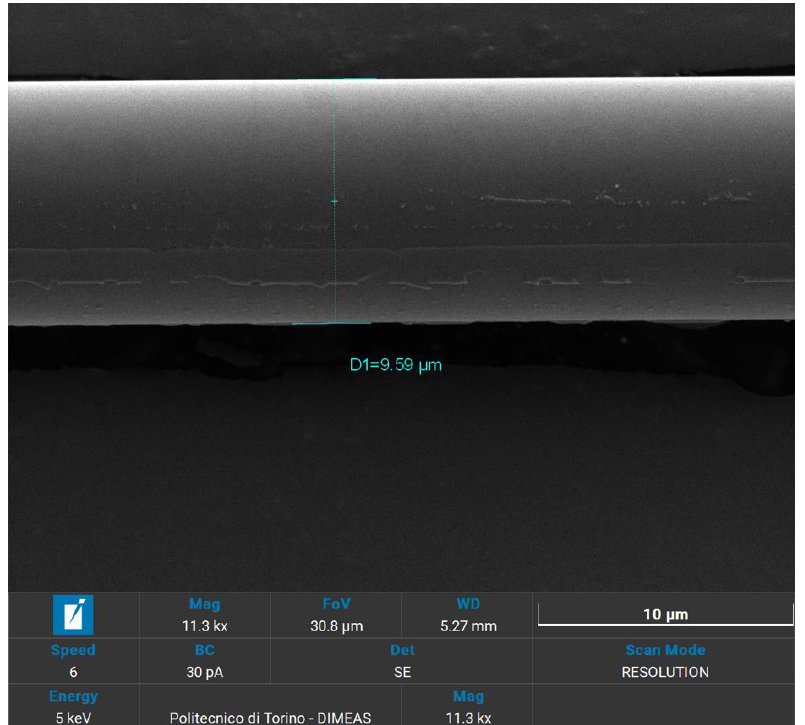
Figure 13. Lateral surface of recycled basalt single